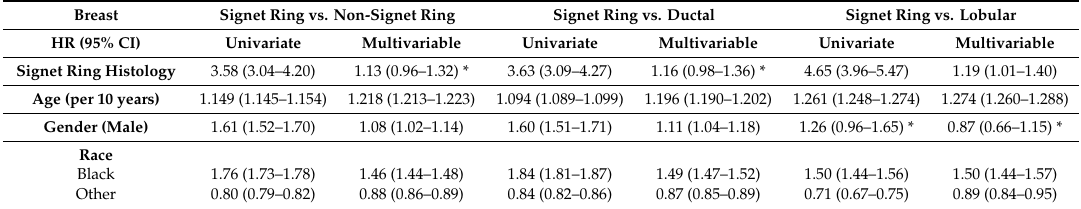
Table 18. Derived univariate and multivariable Cox-proportional hazard ratios (HR) of mortality for breast cancers. Signet Ring vs. Non-Signet Ring Signet Ring vs. Ductal Signet Ring vs.